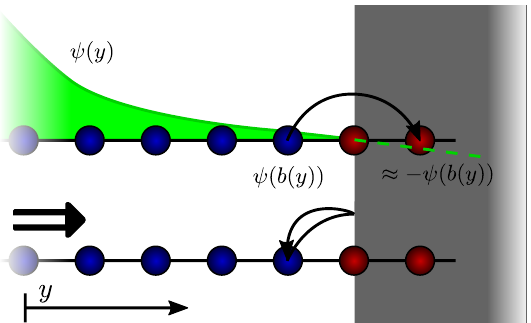
Figure 3: Illustration of the approximation used in immediate vicinity of a boundary in order to improve the approximation of the continuous system by a discretized one, see main text.